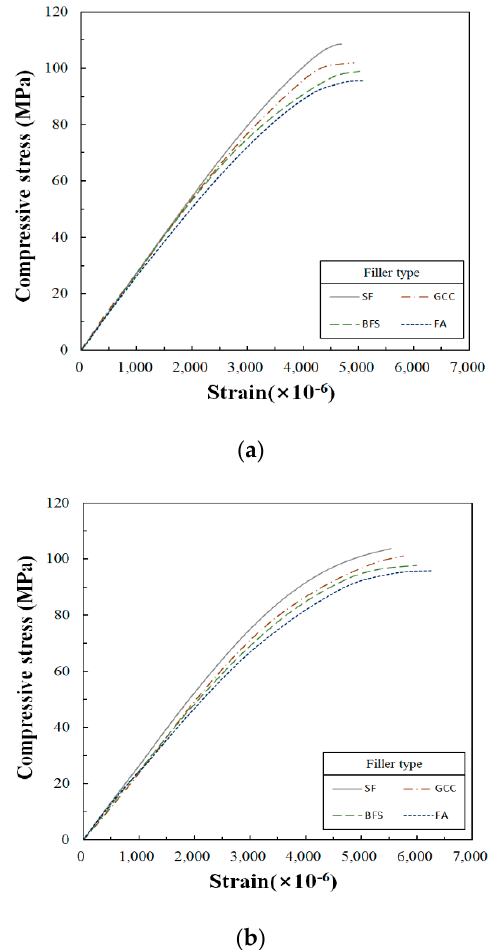
Figure 6. Compressive stress and strain curves by hardener and filler type: ( a ) AAMT hardener and ( b ) CAMT hardener.